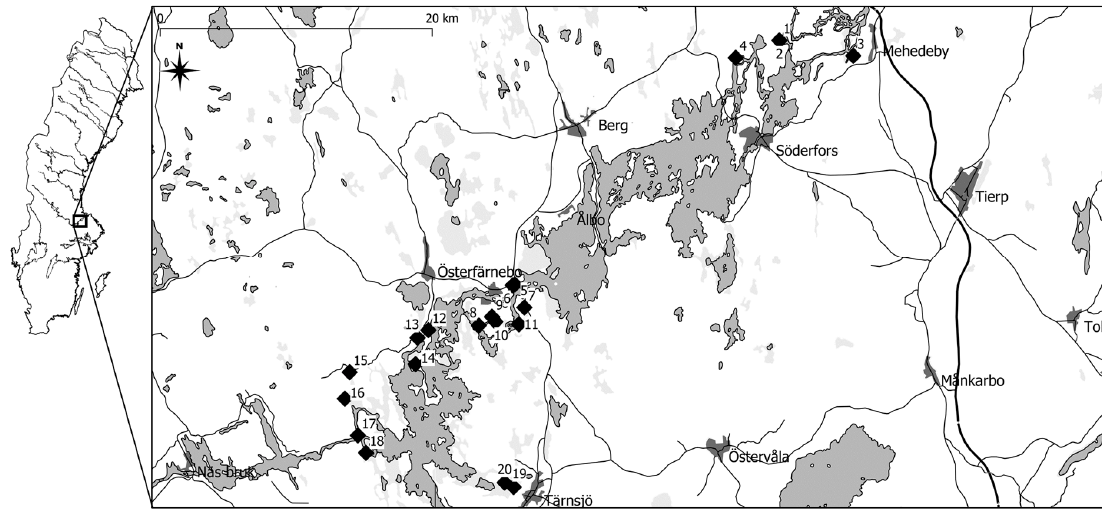
Figure 1. Map of the Lower Dalälven area with sample locations marked with diamonds 1–20. List of all locations in Table S2.